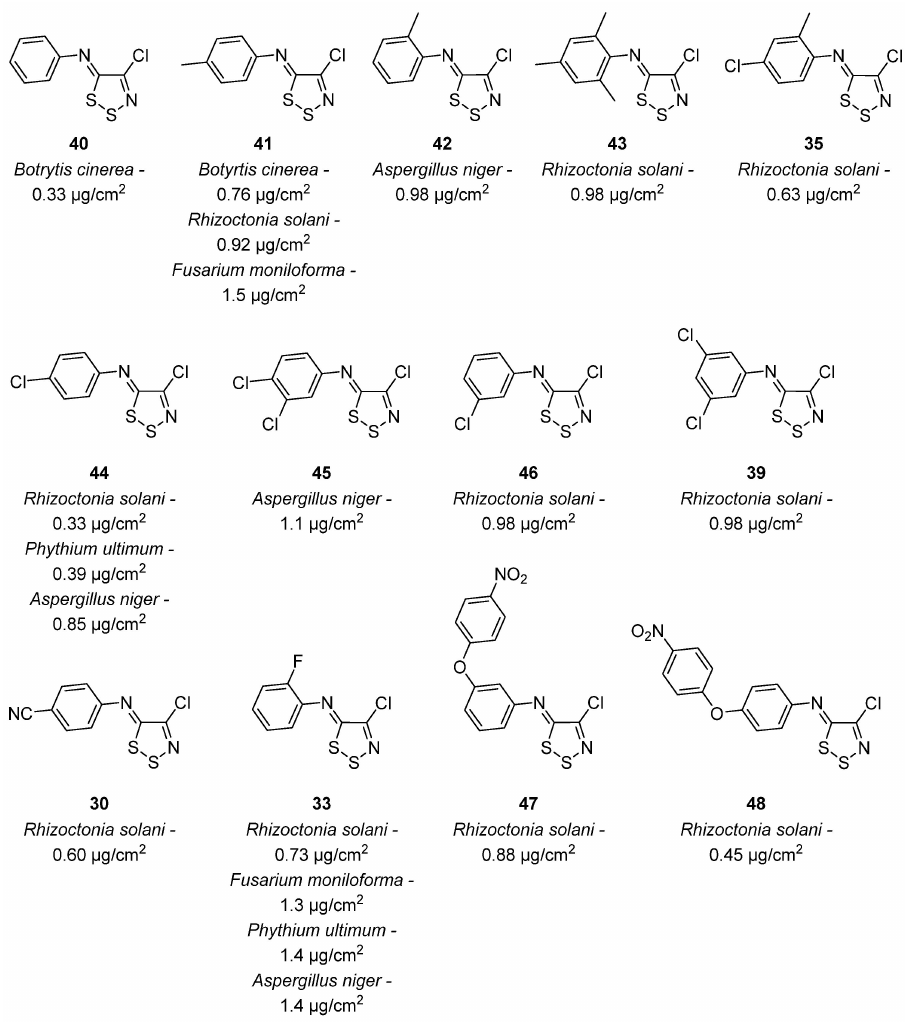
Figure 4. Antifungicidal activities of 1,2,3-dithiazoles, values are amounts required for mycelia inhibition, micrograms/cm 2 for 99% control of fungal